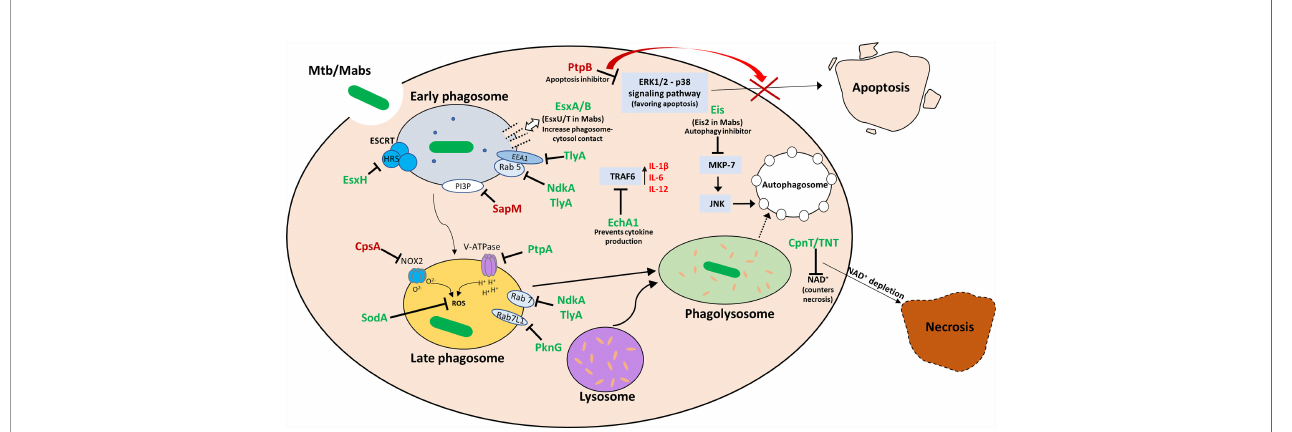
FIGURE 1 | Visual summary of the secreted effectors in Mtb and Mabs and their intracellular targets. Once the bacilli are phagocytosed by the macrophage, it goes through a series of processing stages: early and late phagosome formation, phagosome acidi fi cation and phago-lysosome fusion. Necrosis is an undesirable outcome for the host, while it promotes cell-to-cell spread of the bacteria. Apoptosis, while leading to macrophage death, promotes effective immune response, and is therefore detrimental to the bacteria in the infection process. During each stage, the mycobacteria attempts to block phagosome maturation and acidi fi cation, prevent apoptosis and promote necrosis. Effectors are marked in green when a MABS analog of the Mtb protein is either identi fi ed or is presumed to exist, and in red when no MABS analog has been identi fi ed or